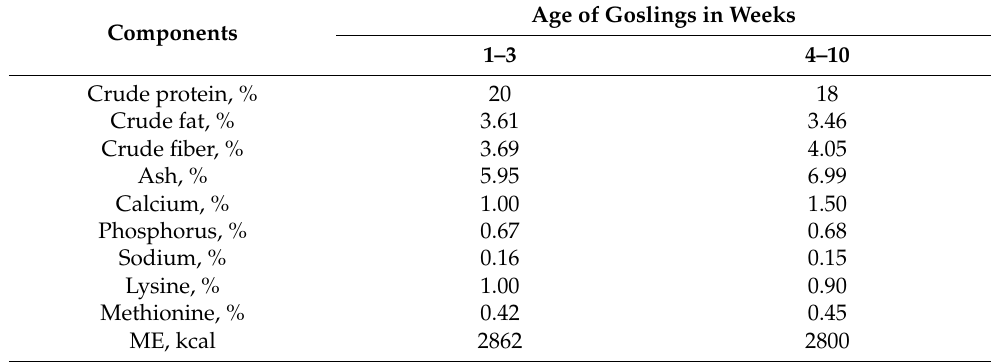
Table 1. Nutrient composition of